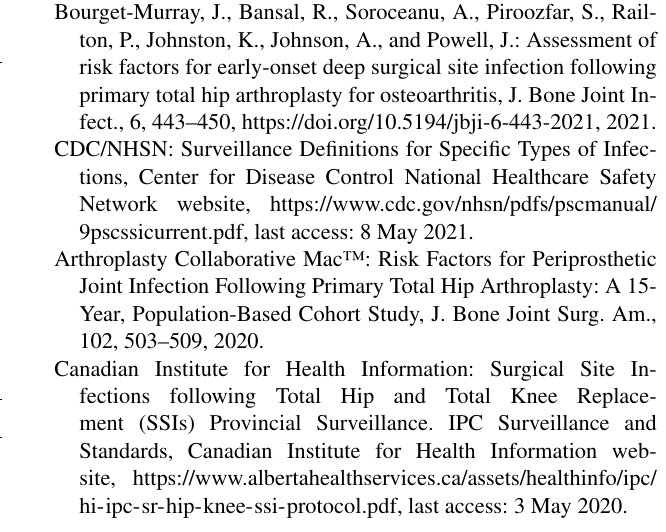
Table 4. Risk factors for early-onset periprosthetic joint infection. Risk